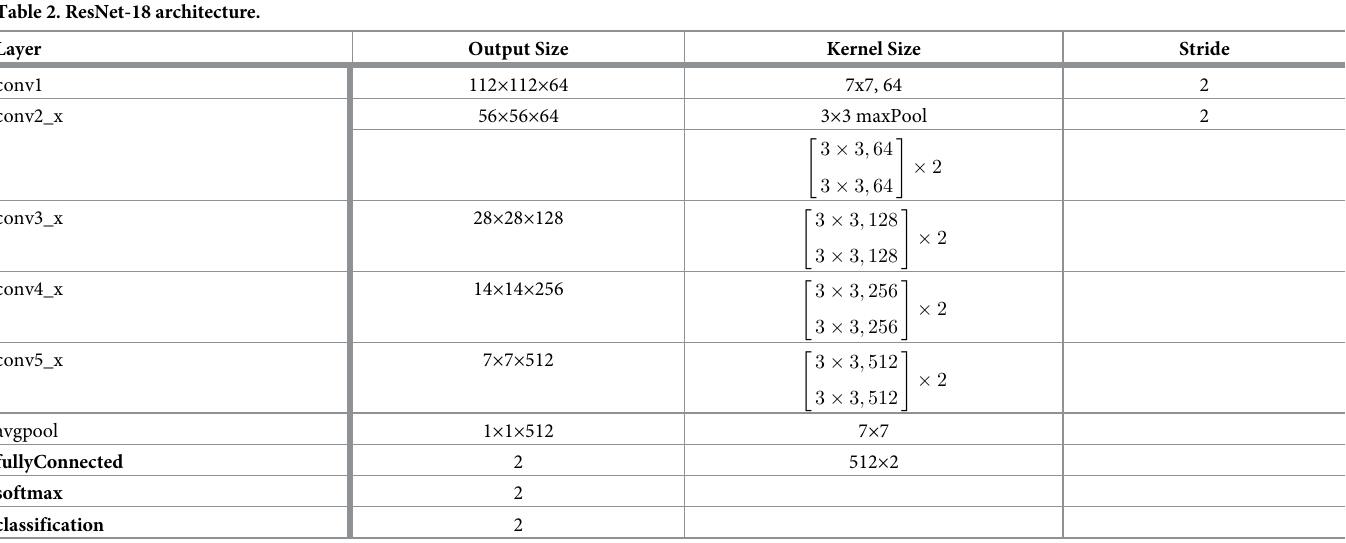
Table 2. ResNet-18 architecture.